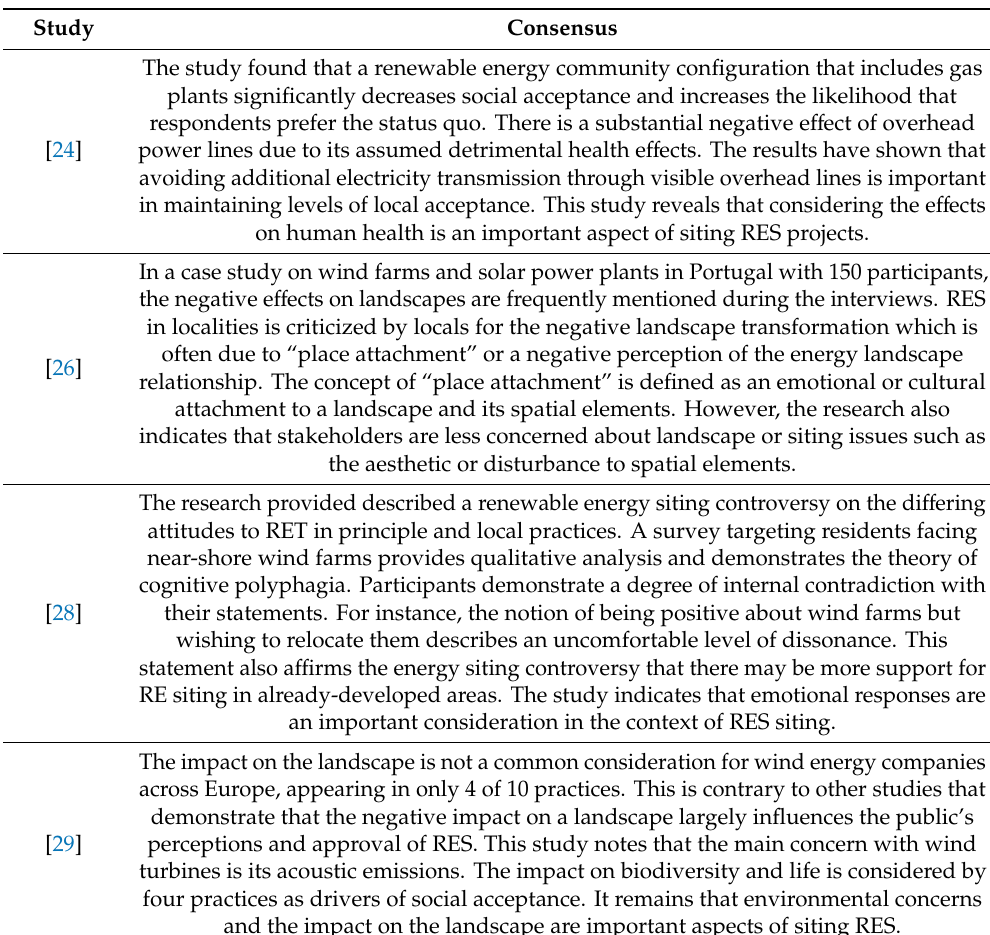
Table 4. Comparing the results of the e ff ect of siting and physical attributes of renewable energy (RE) on social